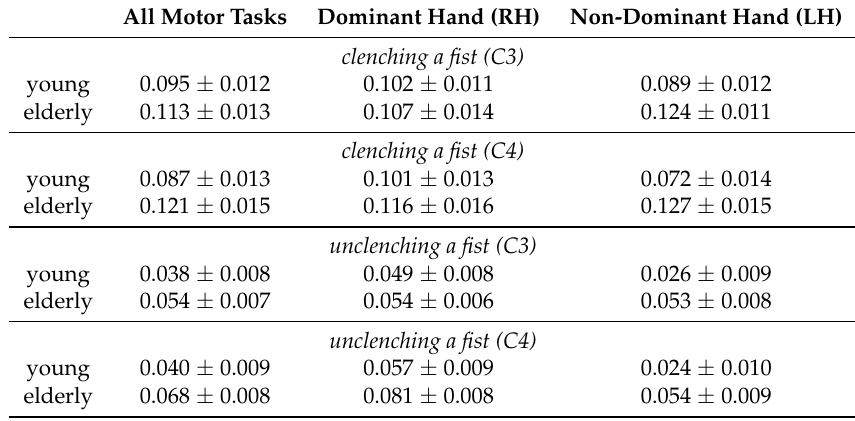
Table 1. Slopes r characterizing different rate of growth in α during execution of motor tasks between young and elderly adults. Data are given as mean ±